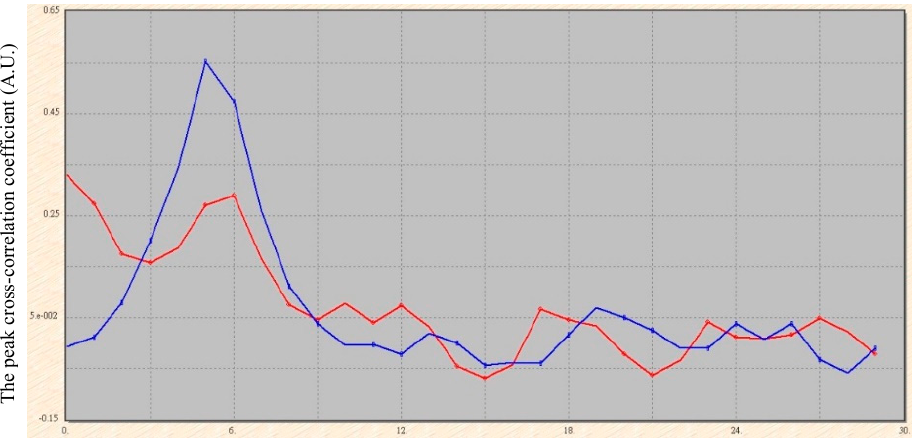
Figure 6. Two normalized cross-correlation coefficient curves acquired when both the blue and red subset images were matched with their corresponding reference templates.